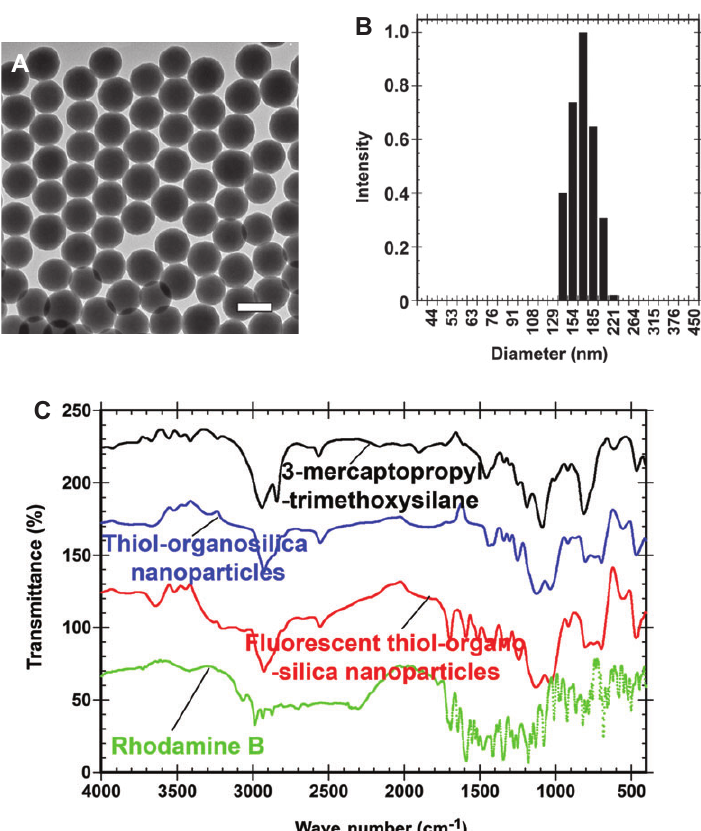
Figure 3 Characterization of fl uorescent organosilica nanoparticles. (A) Transmission electron micrographs of fl uorescent organosilica nano- particles. Scale bar = 100 nm. (B) Dynamic light scattering analysis of fl uorescent organosilica nanoparticles. (C) Fourier transform infrared spectroscopy spectra of 3-mercaptopropyltrimethoxysilane solution (black), thiol-organosilica nanoparticles (blue), fl uorescent thiol-organo- silica nanoparticles (red), and rhodamine B (green). From Ref. [147] ; reproduced with kind permission from